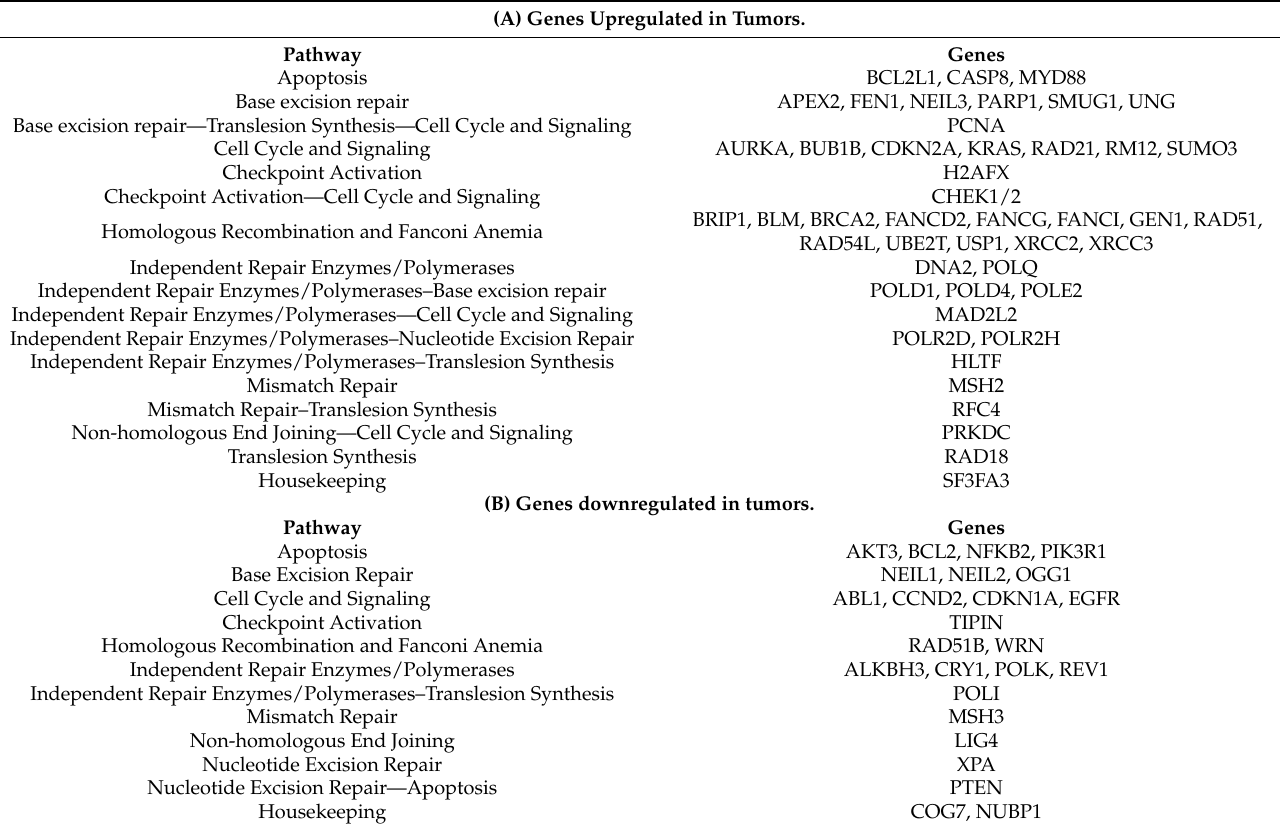
Table 1. Genes significantly differentially expressed in